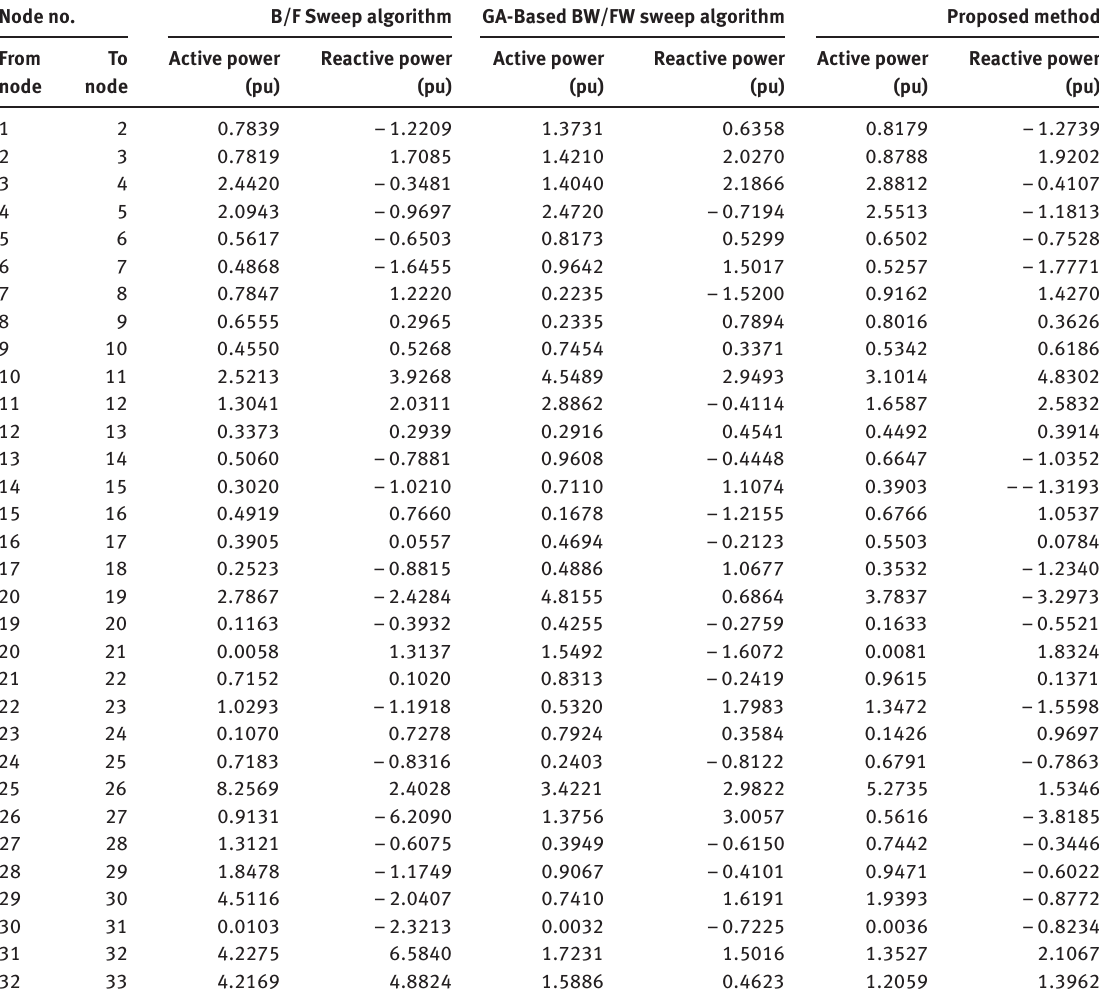
Table 2: Analysis of Active and Reactive Power. Node no.